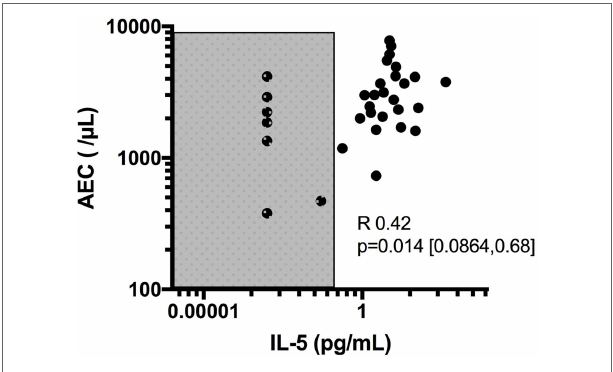
FiGUre 1 | Correlation of absolute eosinophil count (AEC) with IL-5 levels and demonstration of subjects with undetectable IL-5 despite elevated eosinophil counts. Shaded area denotes values below the limit of detection of IL-5 (0.1 pg/mL) in the assay used.